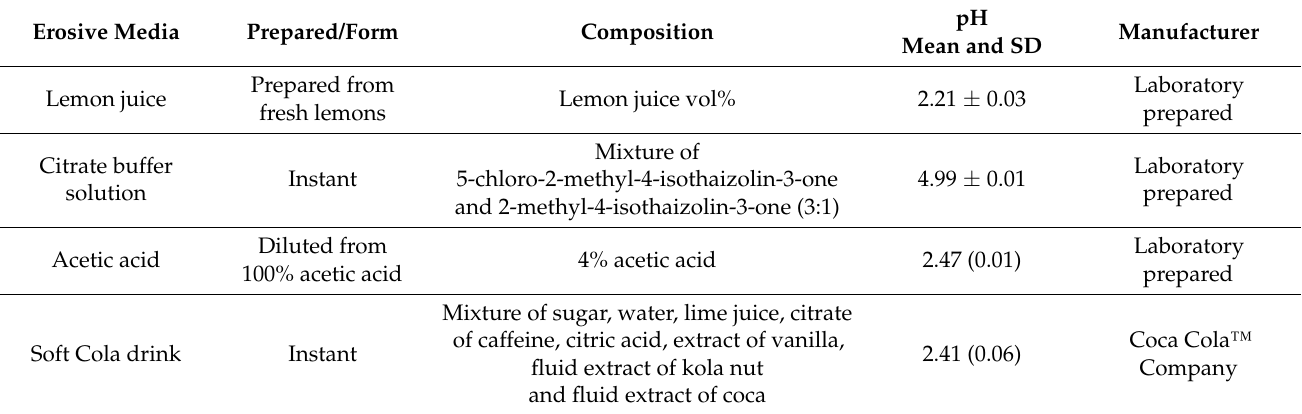
Table 5. Details of type, preparation, composition, measured pH and manufacturer of the immersion media used for the